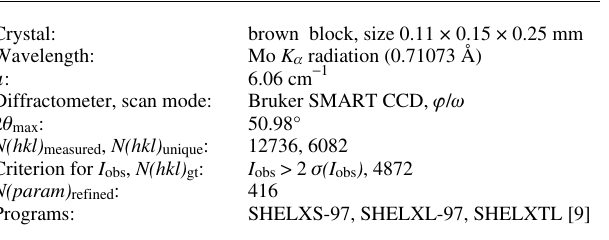
Table 1. Data collection and handling.